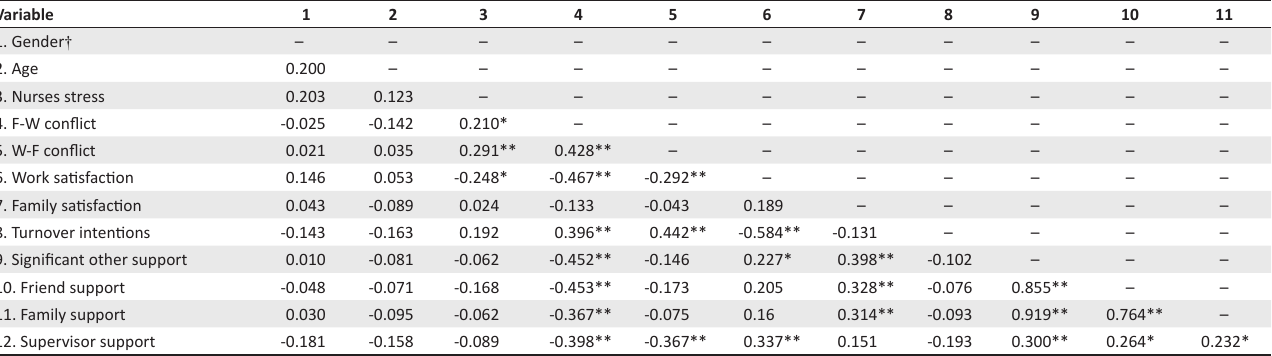
TABLE 1: Correlation analyses of all study variables ( N = 91).